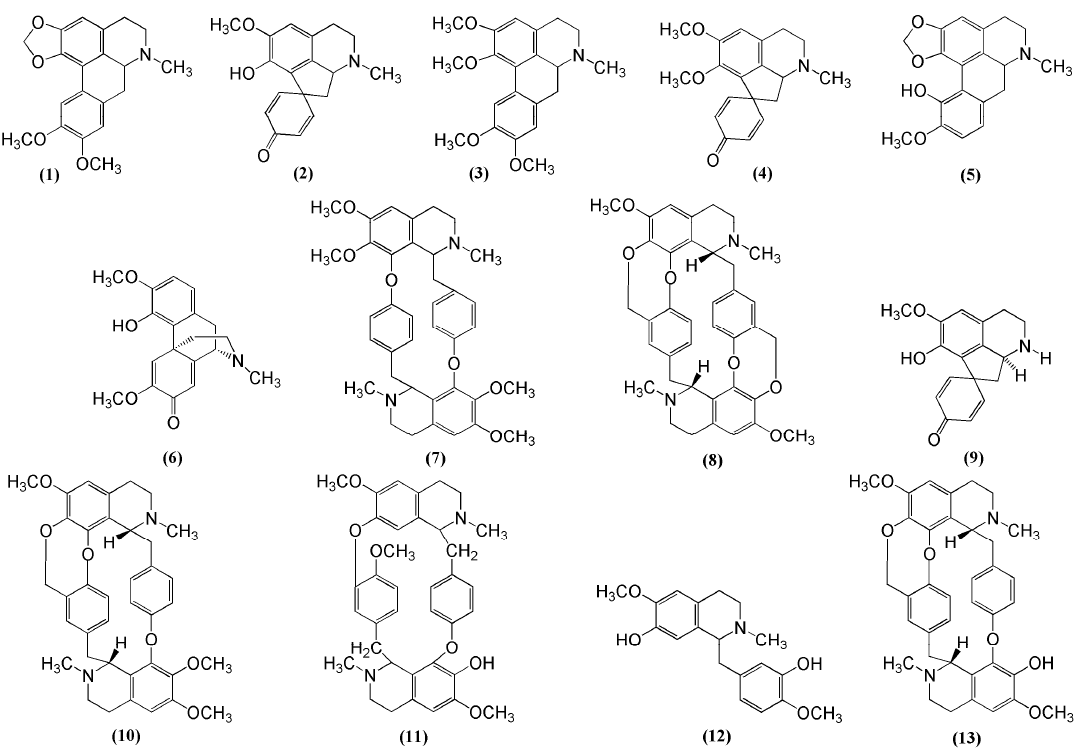
Figure 2. Chemical structures of the major alkaloids ( 1-13 ) isolated from Cissampelos capensis . dicentrine ( 1 ), glaziovine ( 2 ), lauroscholtzine ( 3 ), pronuciferine ( 4 ), bulbocapnine ( 5 ), salutaridine ( 6 ), cycleanine ( 7 ), cissacapine ( 8 ), crotsparine ( 9 ), insularine ( 10